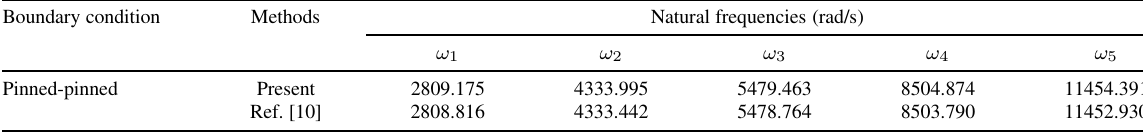
Table 1 Comparison of natural frequencies of a uniform beam used in example 1